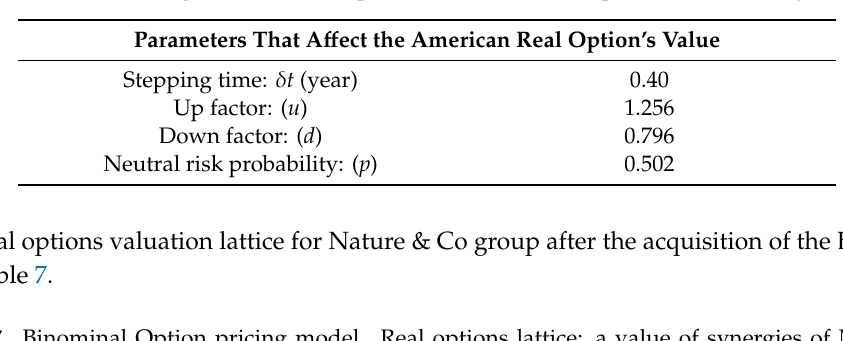
Table 7. Binominal Option pricing model. Real options lattice: a value of synergies of Natura’s acquisition of The Body Shop (in US$